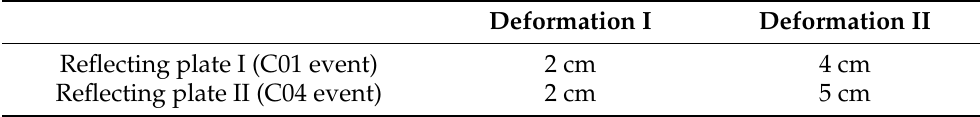
Table 2. The artificial deformation quantities.